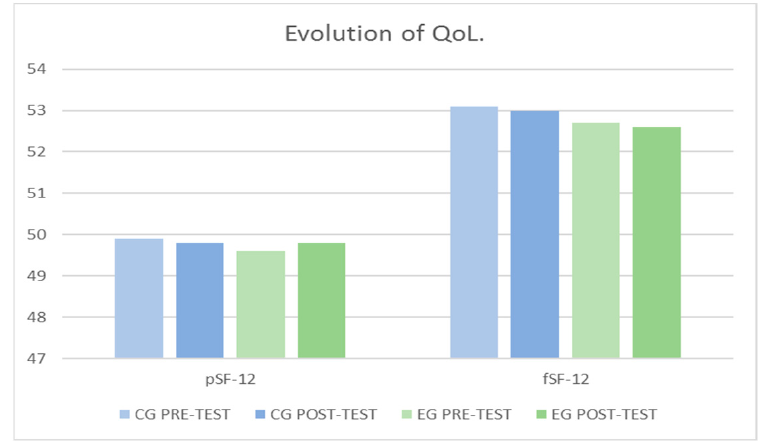
Figure 5. Evolution of the two dimensions of QoL between groups and pre-post-test.